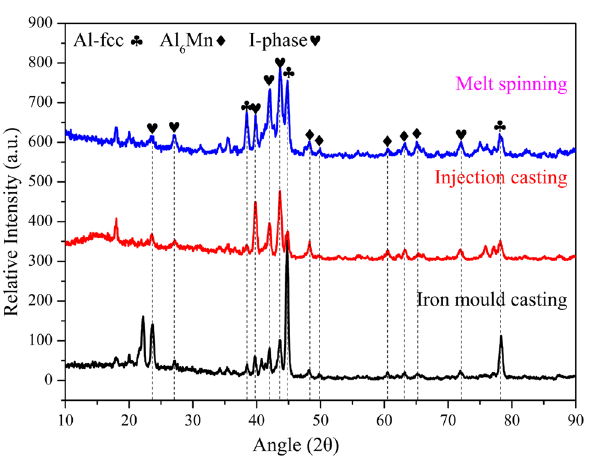
Figure 4: XRD patterns of Al – Mn – Fe alloy at di ff erent cooling rates.